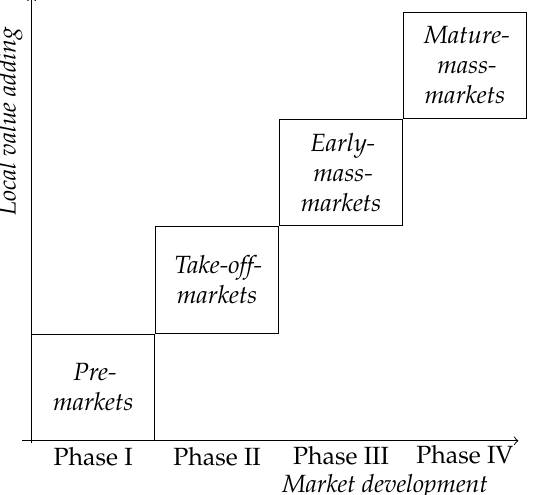
Figure 2. Strategies of companies in developing countries according to